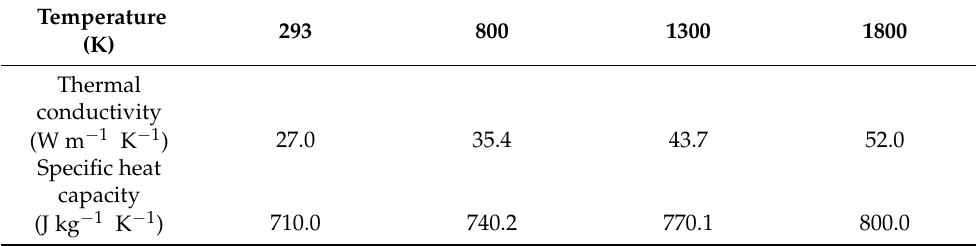
Table 2. Temperature dependent properties of the mild